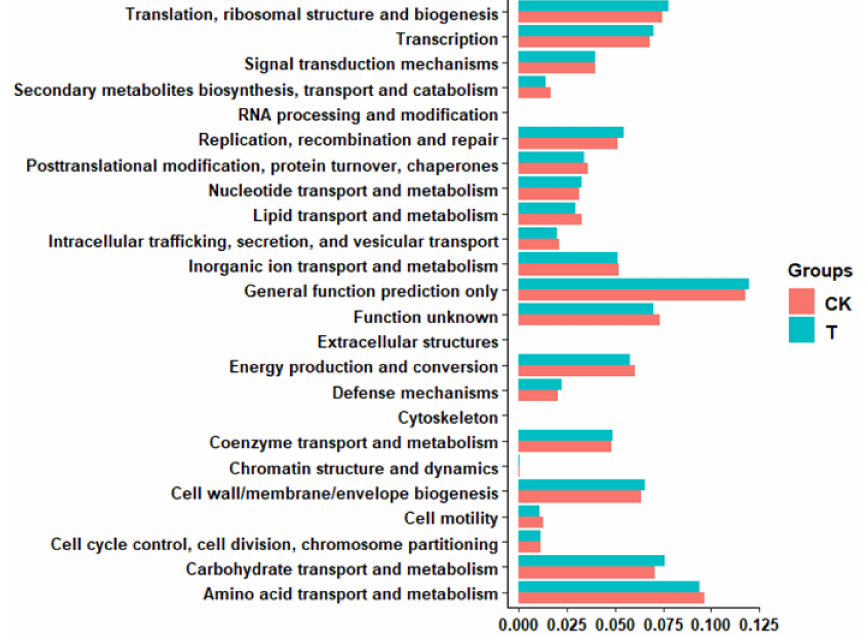
Figure 6. Comparison of predicted Cluster of Ortholog Groups (COG) functions of gut bacteria of Grapholita molesta before and after ciprofloxacin feeding. The X-axis represents the abundance value of functional categories, and the Y-axis represents the different function categories. CK: control; T: treatment with